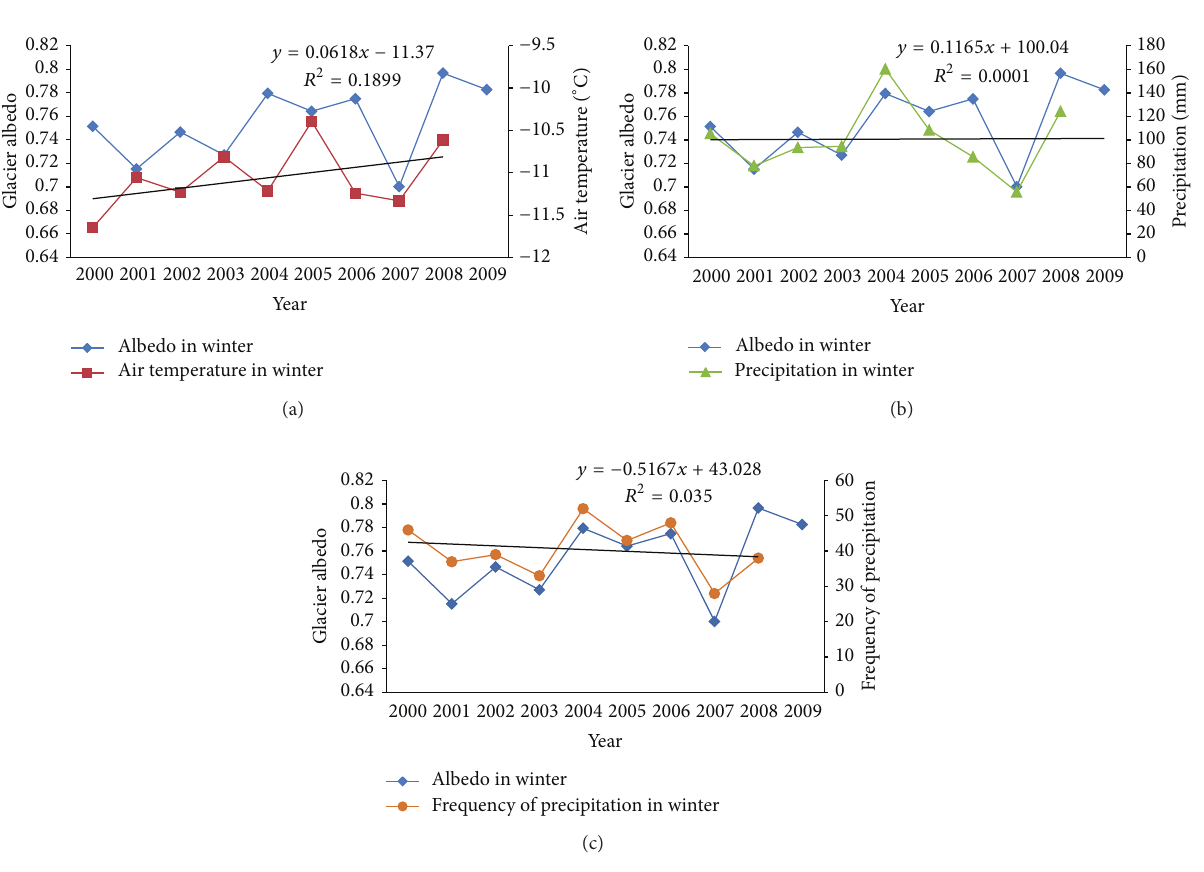
Figure 8: Annual variations of glacier albedo, meteorological factors in winter during 2000–2009. (a) Air temperature. (b) Precipitation levels. (c) Frequency of precipitation.